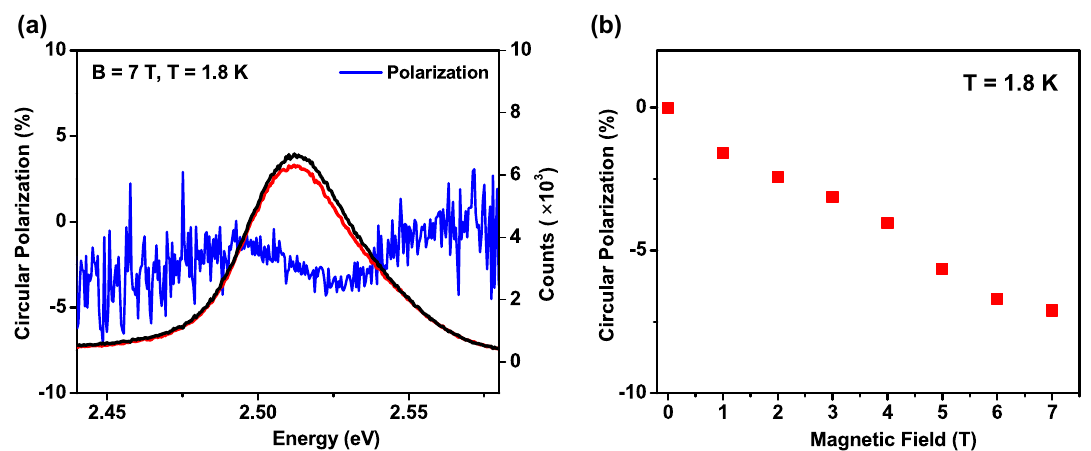
Figure 4: Circular polarization with the effect of magnetic field. (a) Right circularly polarized (RCP) (black) and left circularly polarized (LCP) (red) components of PL of the Cu-doped sample at T = 1.8 K and B = 7 T. (b) Circular polarization of the exciton as a function of magnetic field (B) at a particular temperature ( T = 1.8 K) for the Cu-doped CdSe NPLs